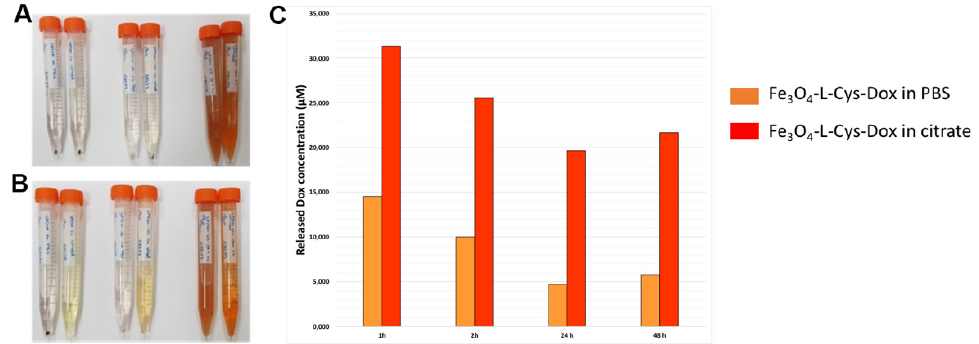
Figure 8. Dox release in PBS buffer (pH = 7.4) and citrate buffer (pH = 3) after ( A ) 1 and ( B ) 24 h of incubation. ( C ) The estimated Dox concentration upon release from the Fe 3 O 4 -L-Cys-Dox NP samples (200 µ g/mL) after 1, 2, 24 and 48 h by measuring the fluorescence intensity at 480 nm excitation and 593 nm emission.